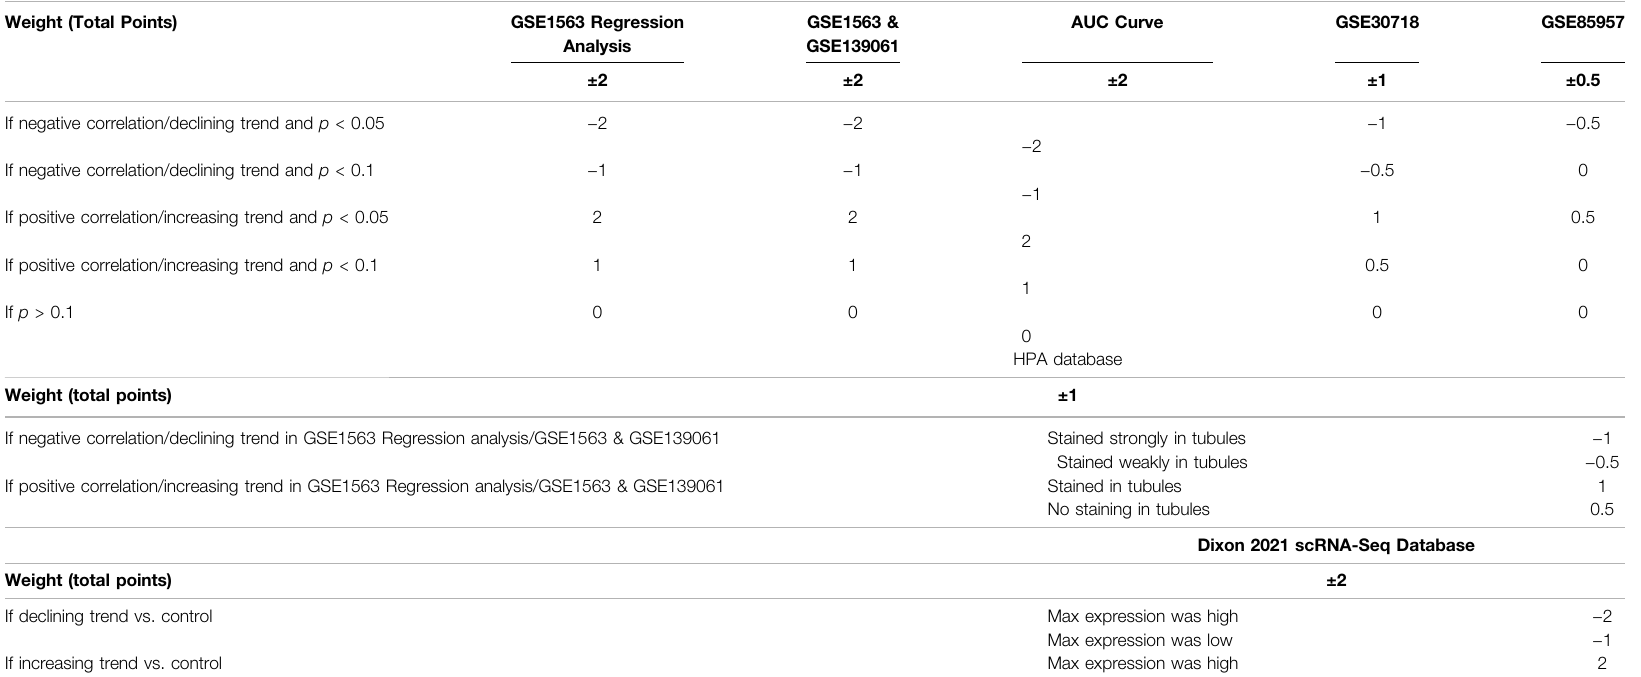
TABLE 2 | Standard of scoring of 14